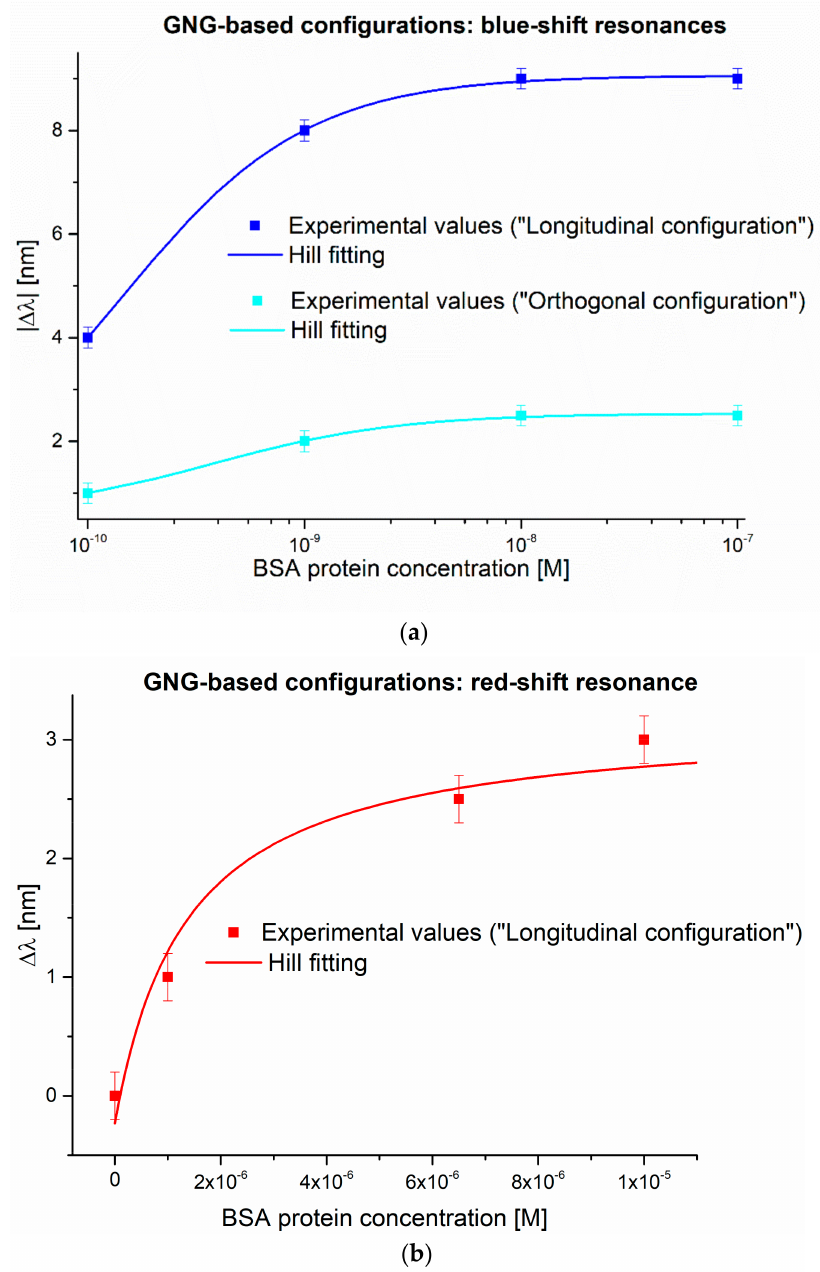
Figure 7. BSA dose-response curves with Hill fitting of the data and error bars relative to ( a ) GNG- based longitudinal and GNG-based orthogonal blue-shift resonances and ( b ) GNG-based longitudinal red-shift